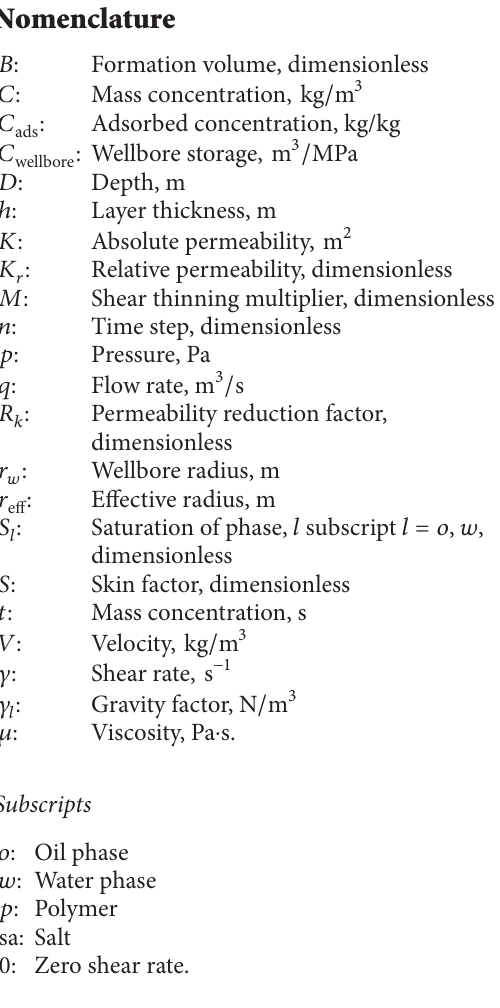
influenced by the 𝑀 - 𝑉 shear thinning curve and the polymer